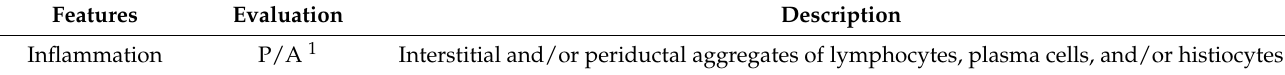
Table A7. Histopathological features evaluated in the pancreas.